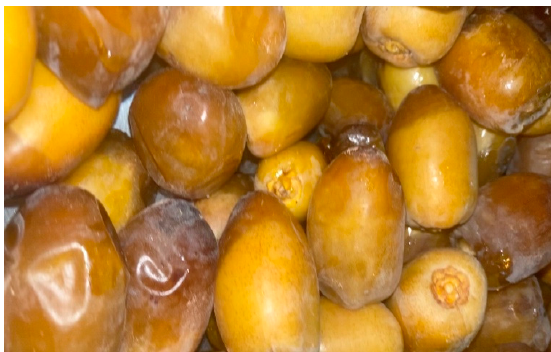
Figure 13. Sample of Al-maktoumi dates.